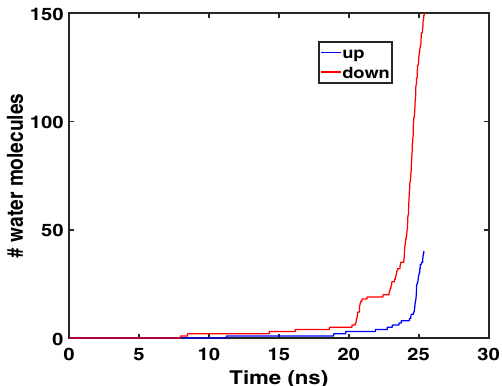
Figure 4. The total number of water molecules translocated across the membrane (the moving-up(exiting) & the moving-down(entering)) vs. the simulation time.